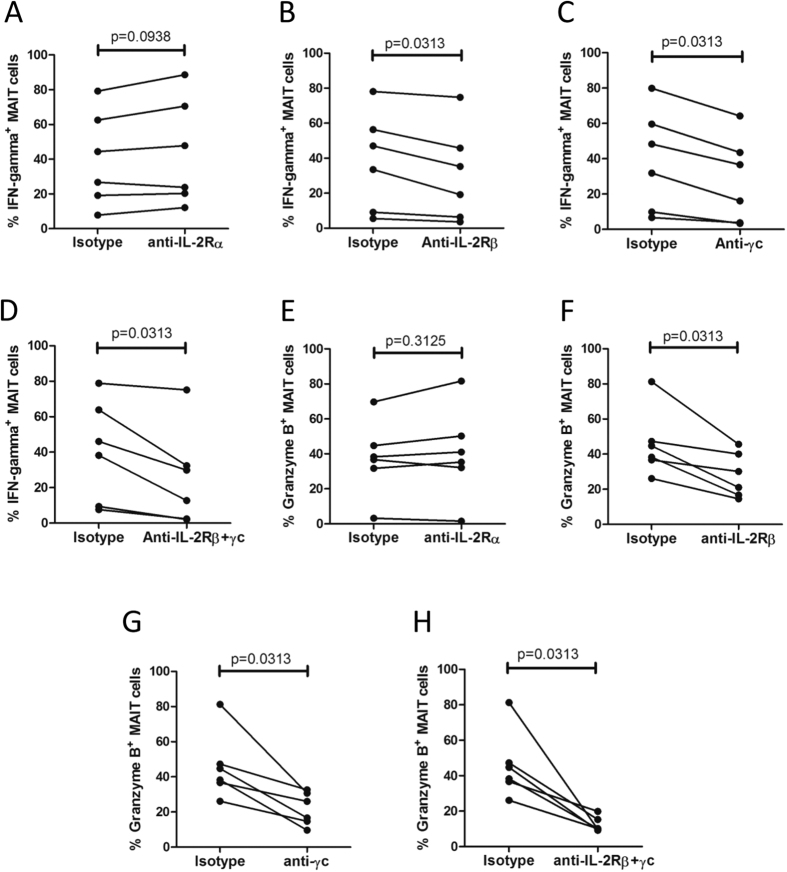
Blockade of γc and IL-2Rβ receptors resulted in reduced immune response of MAIT cells from tuberculous pleural effusions.(A) Blockade of IL-2Rα did not have significant effect on IFN-γ response in MAIT cells stimulated with Mtb lysates. (B–C) Reduced IFN-γ response in MAIT cells was observed when IL-2Rβ (B) and γc receptors (C) were blocked with antibodies respectively. (D) Blockade of both IL-2Rβ (B) and γc receptors resulted in decreased IFN-γ response in MAIT cells. (E) Blockade of IL-2Rα did not have significant effect on granzyme B production in MAIT cells. (F–G) Blockade of IL-2Rβ (F) or γc receptor (G) led to significantly reduced production of granzyme B in MAIT cells. (H) Combined blocking of both IL-2Rβ and γc receptors resulted in even more reduced production of granzyme B. The non-parametric Wilcoxon signed-rank test was used for statistical analysis.